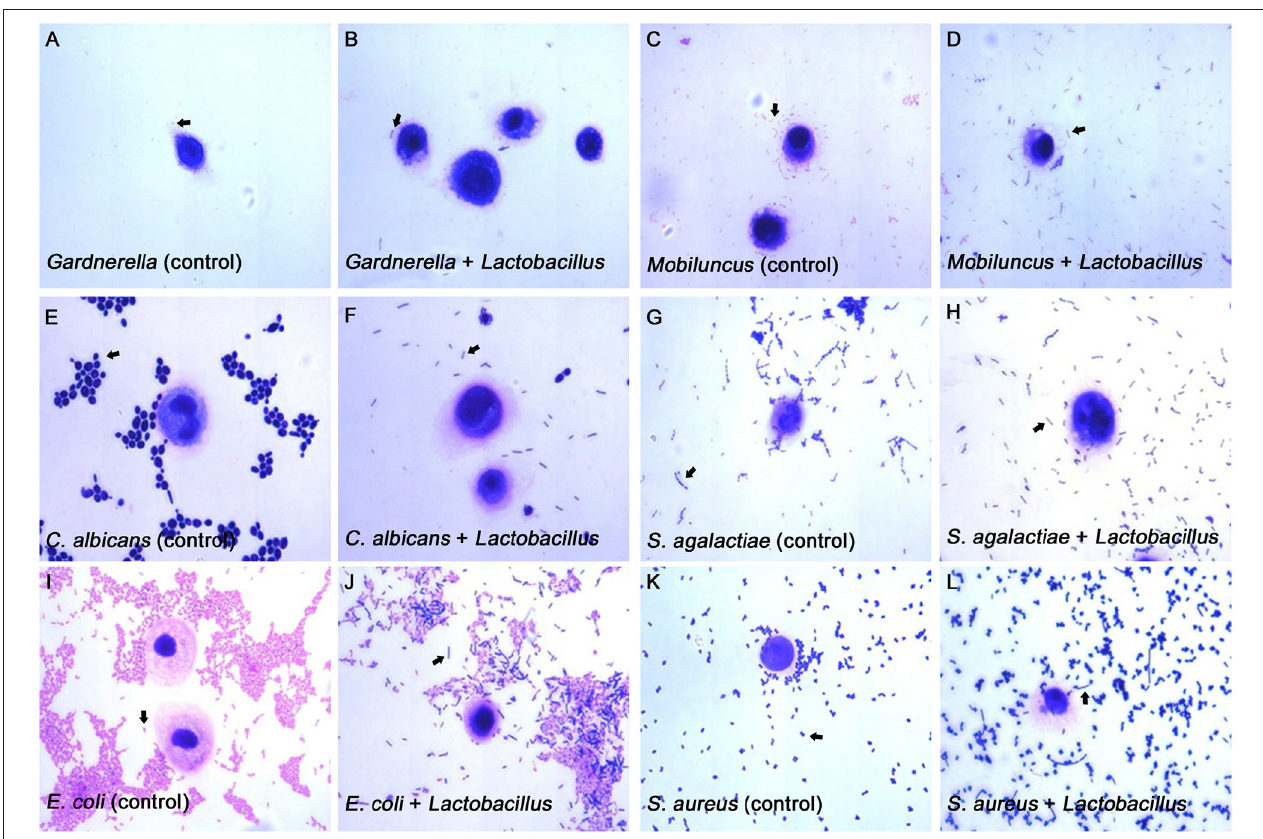
FIGURE 4 | Micrographs of the inhibitory effects of Lactobacillus on pathogen adhesion to the VK2/E6E7 VECs. (A–L) These micrographs illustrate the pathogen adhesion to the VK2/E6E7 VECs in the control and experimental groups. (A,C,E,G,I,K) . These micrographs illustrate pathogen adhesion to the VK2/E6E7 VECs in each control group. Both Lactobacillus and pathogens were identified by their color and morphology after Gram staining. In panel (A) , the arrow refers to Gardnerella , which appears as a red short rod. In panel (C) , the arrow refers to Mobiluncus , which appears as a red curved rod. In panel (E) , the arrow refers to C. albicans , which appears as a purple sphere or oval. In panel (N) , the arrow refers to S. agalactiae , which appears as a purple chain spheroid. In panel (I) , the arrow refers to E. coli , which appears as a red rod. In panel (K) , the arrow refers to S. aureus , which appears as a purple globule. (B,D,F,H,J,L) These micrographs illustrate both the pathogens and Lactobacillus that adhere to the VK2/E6E7 VECs after Lactobacillus antagonization. In panel (B,D,F,H,J,L) , the arrows refer to Lactobacillus , which appears as a purple long